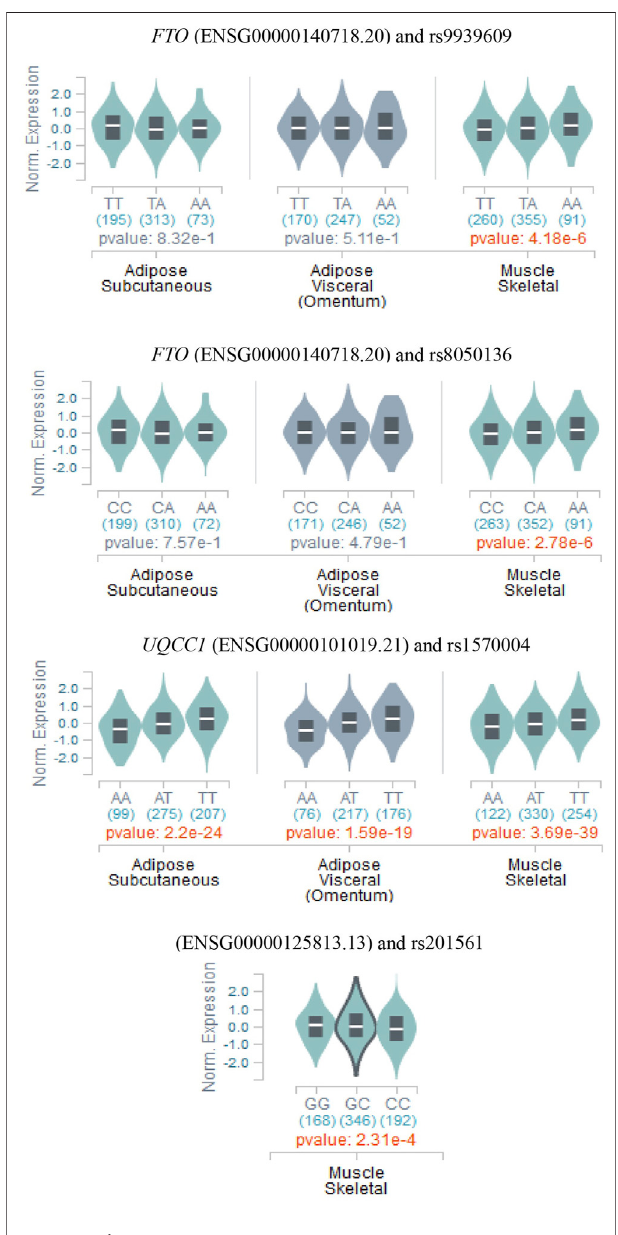
FIGURE 4 | The relationship between the genotypes of the signi fi cant SNPs discovered by HCDC method and eQTL in subcutaneous adipose tissue, visceral adipose tissue, and muscle tissue (data are from GTEx